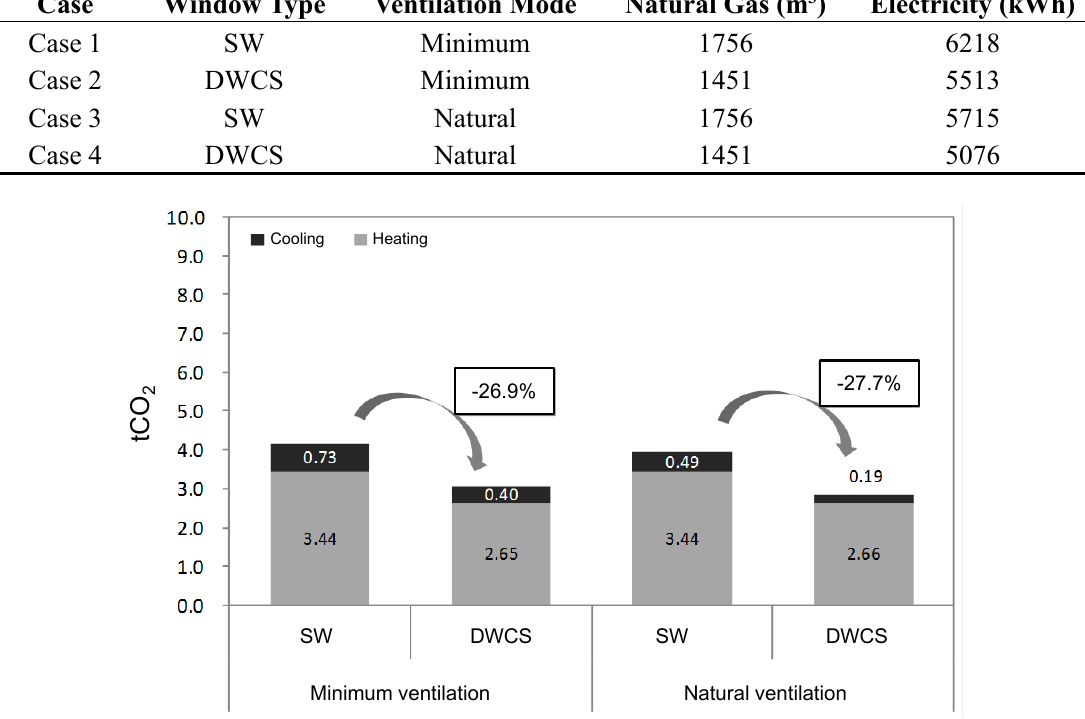
Figure 10. Reduction in annual CO 2 emissions for space